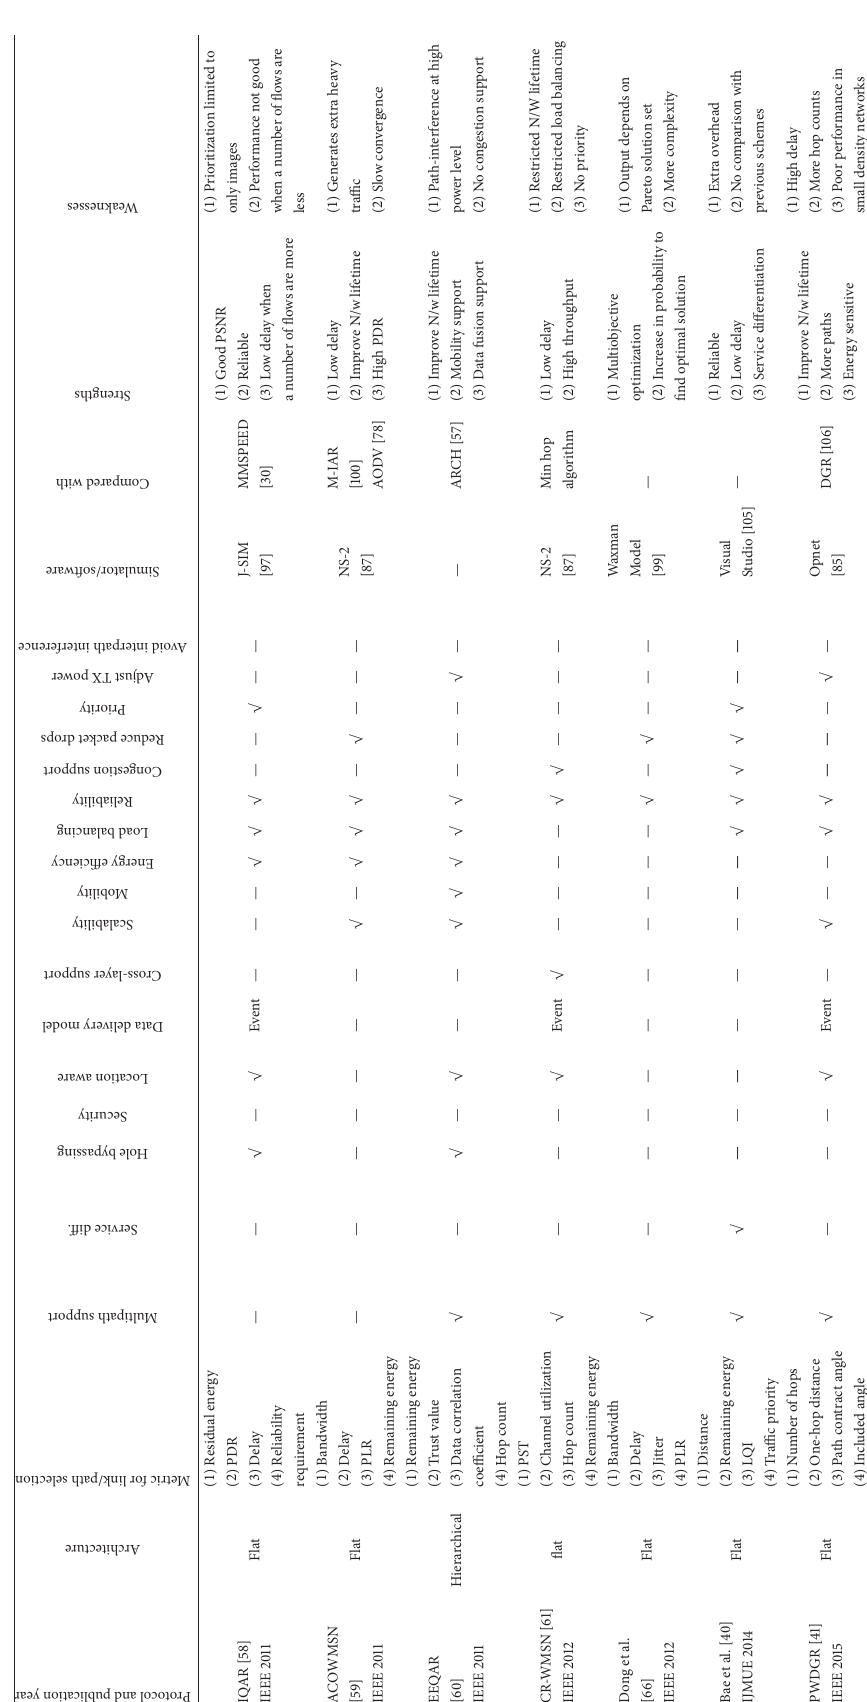
Protocolandpublicationyear